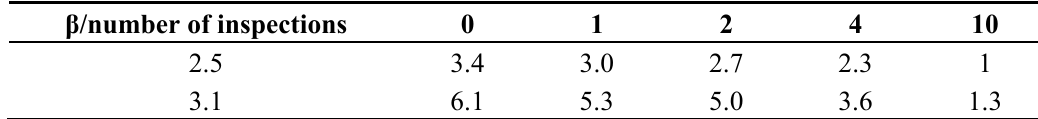
Table 19. Required FDF values for minimum cumulative reliability level. SN-curve: “With cathodic protection”. Inspections with the Eddy Current technique.